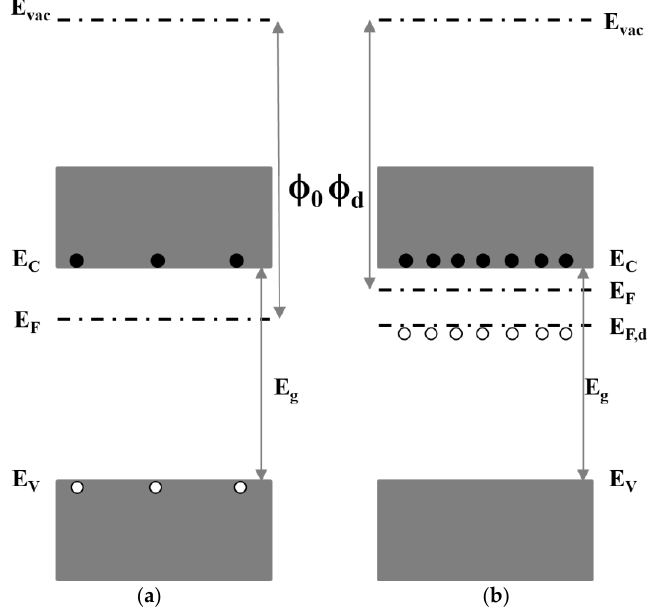
Figure 5. Schematic diagram of the energy level without ( a ) and with ( b ) oxygen deficiency in MoO x . With the introduction of oxygen deficiency, the work function of MoO 3 ( ϕ 0 ) decreases to ϕ d .